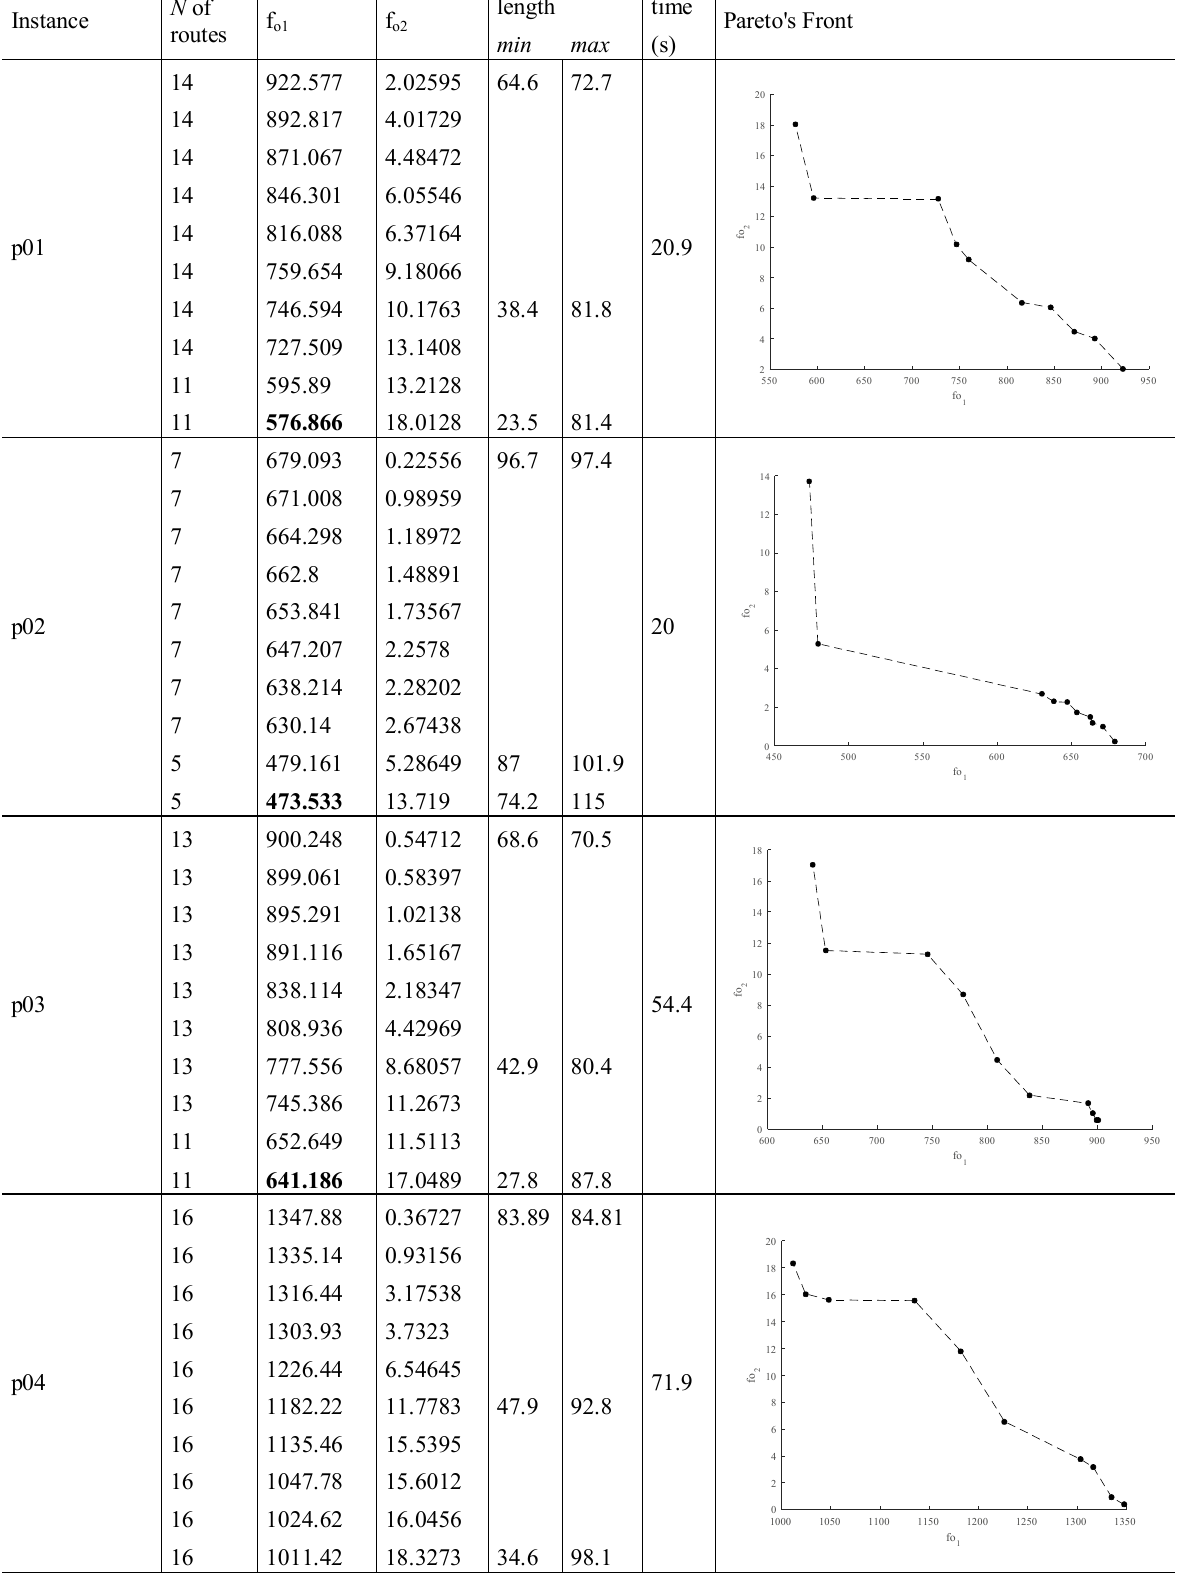
Computational results for instances used by Cordeau, et al.